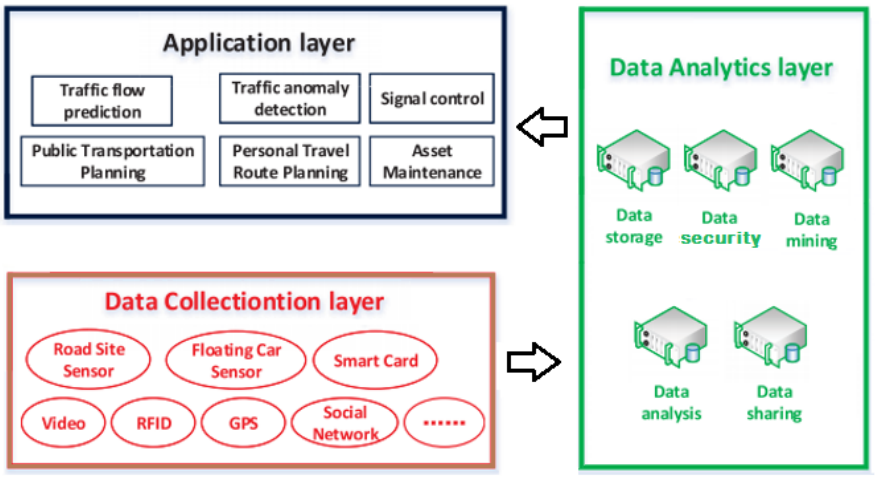
Figure 3. Big data analytics framework in ITS, modified based on [29].